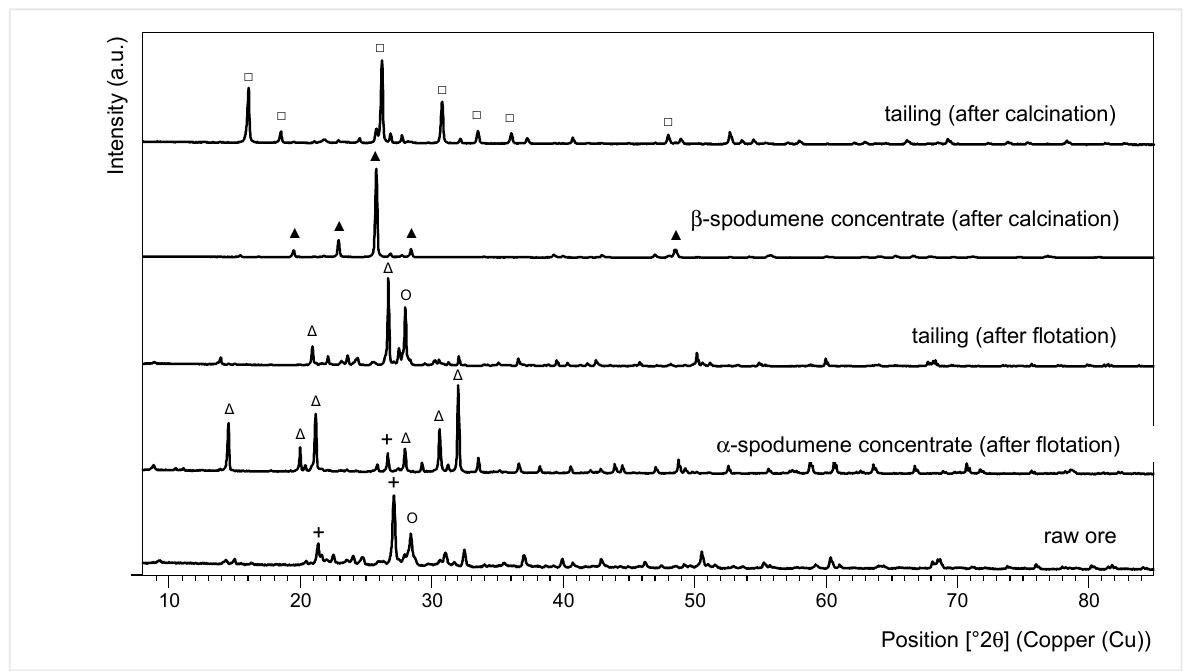
Figure 36. XRD patterns from lithium ore, concentrates and tailing after flotation and calcination, Δ — α -spodumene, ▲ — β -spodumene, Ο —albite, +—quar tz , □ —analcime, modified after Norberg et al. (2020) [37].